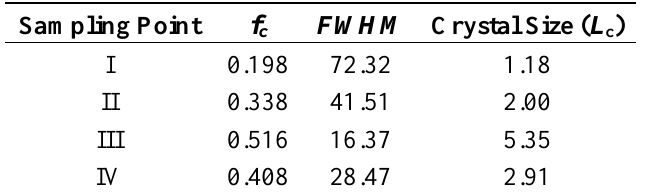
Table 3. Orientation and crystallite size for fibers spun into a 66.6 wt% DMAc/H 2 O coagulation bath obtained from WAXD.